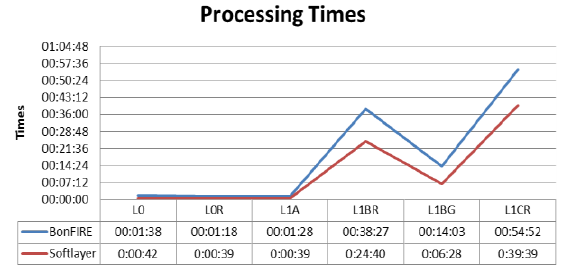
Figure 2 Comparison between BonFIRE's processing time